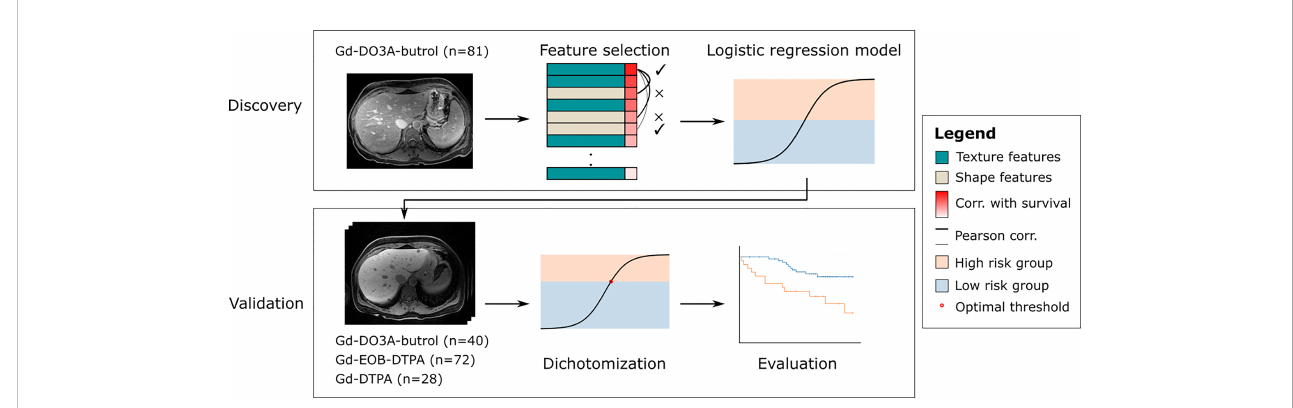
FIGURE 1 Overview of the data split and the general discovery and validation work fl